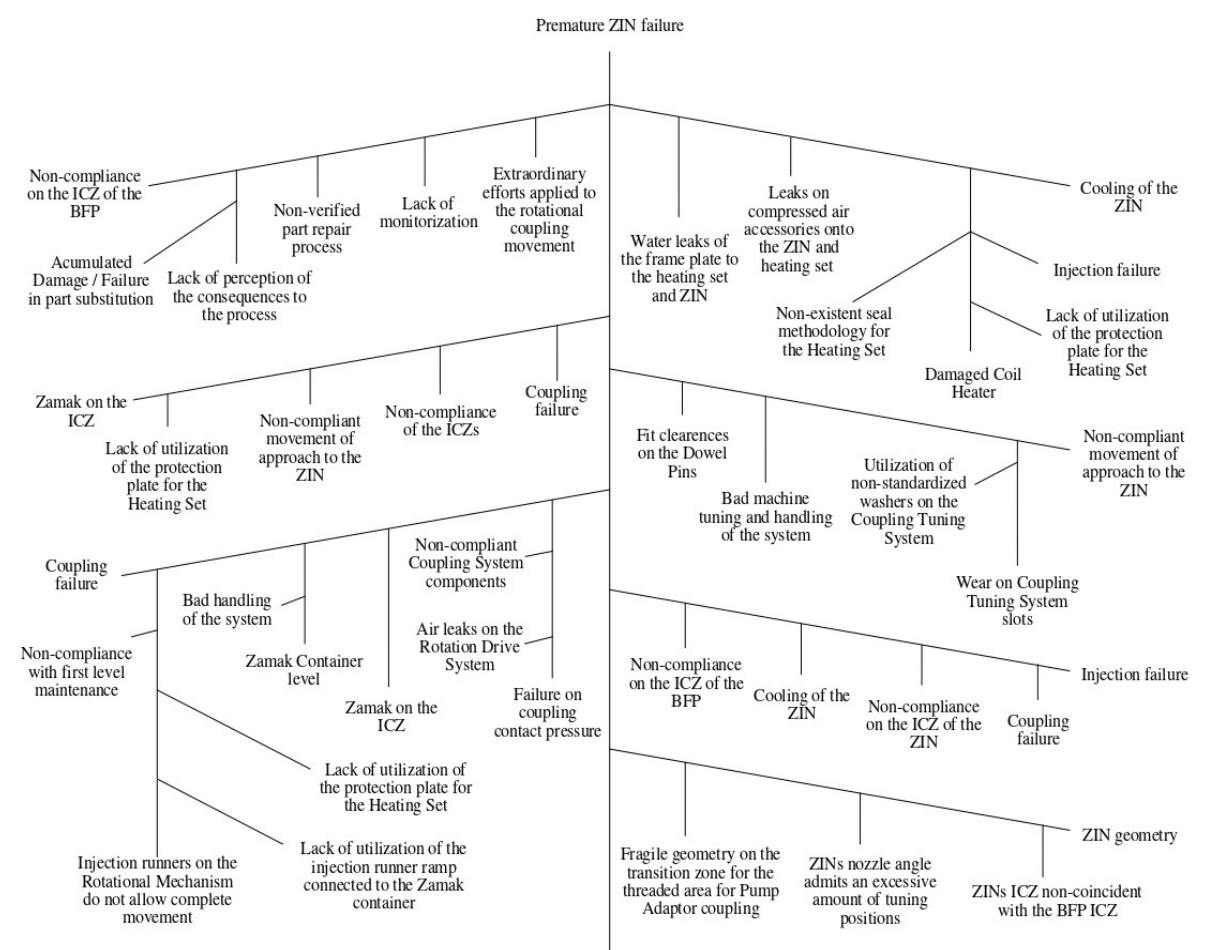
Figure 17. Ishikawa diagram for ZINs premature